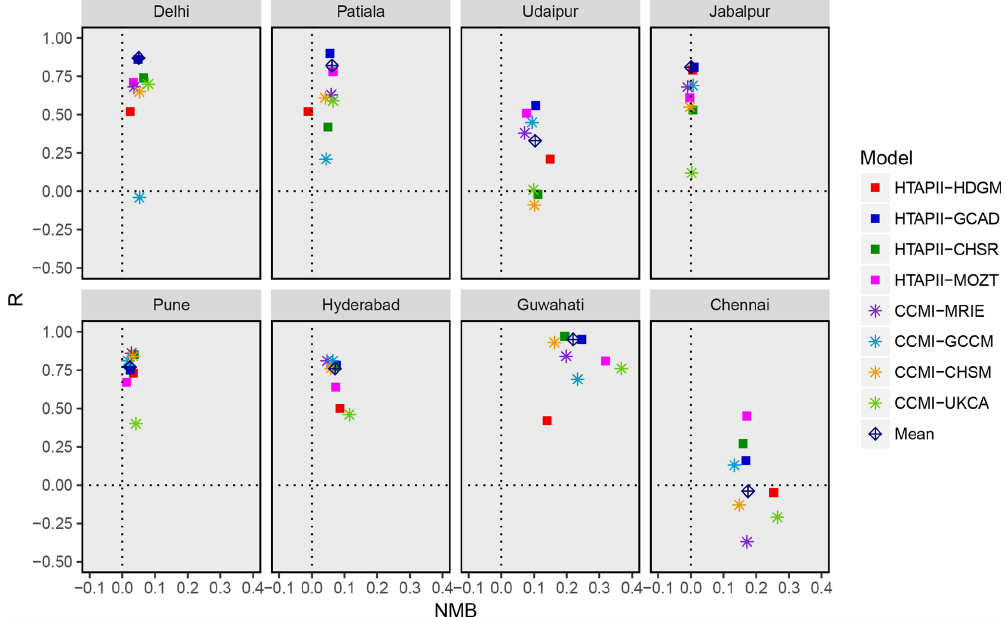
Figure 6. Scatter plot of Pearson correlation coefficient ( R ) values against normalised mean bias (NMB), highlighting the models perfor- mance in surface ozone at each